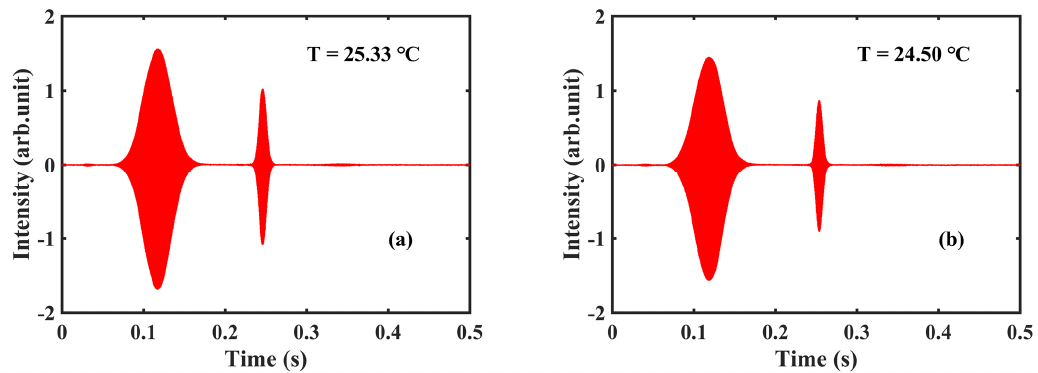
Figure 5. ( a ) Cross-correlation patterns in 25.33 °C; ( b ) cross-correlation patterns in 24.50 °C.